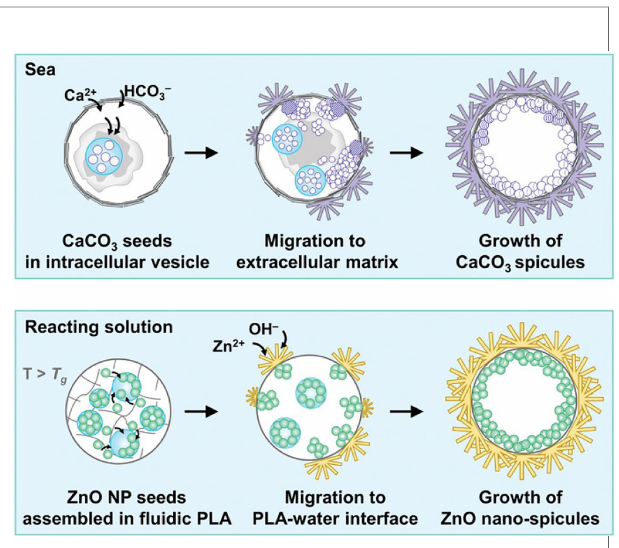
FIGURE 5 | The formation process of arti fi cial micro-urchin with ZnO nano- spicules (115). Copyright 2021,